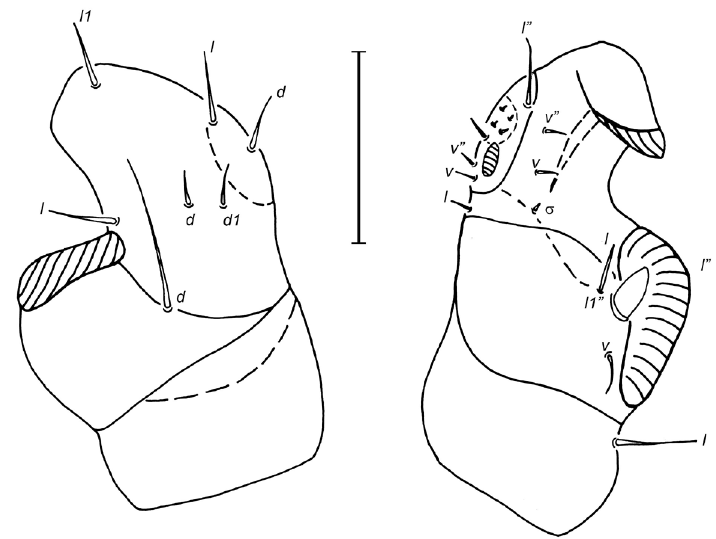
Figure 3. Ioanella mimon , male, leg I. A Dorsal view B Ventral view. Scale bar: 25